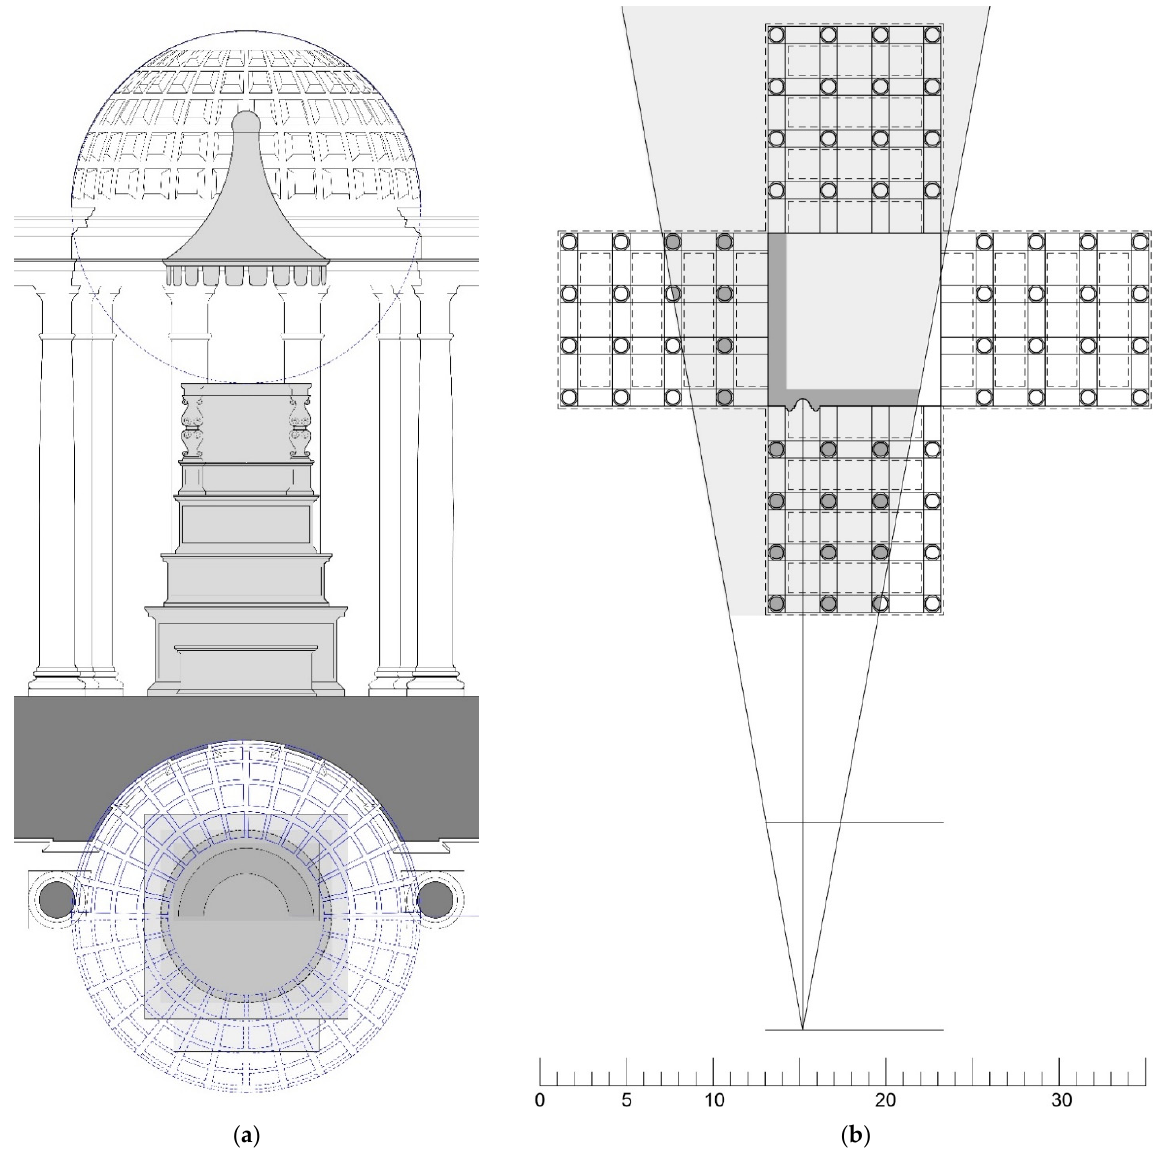
Figure 12. ( a ) Perspective restitution in plan and elevation from Raffaello’s The Madonna of the Baldacchino with the throne in light gray; ( b ) Perspective restitution in plan with the visual cone from Perugino’s The Healing of the Lame with the effective visible part in light gray.